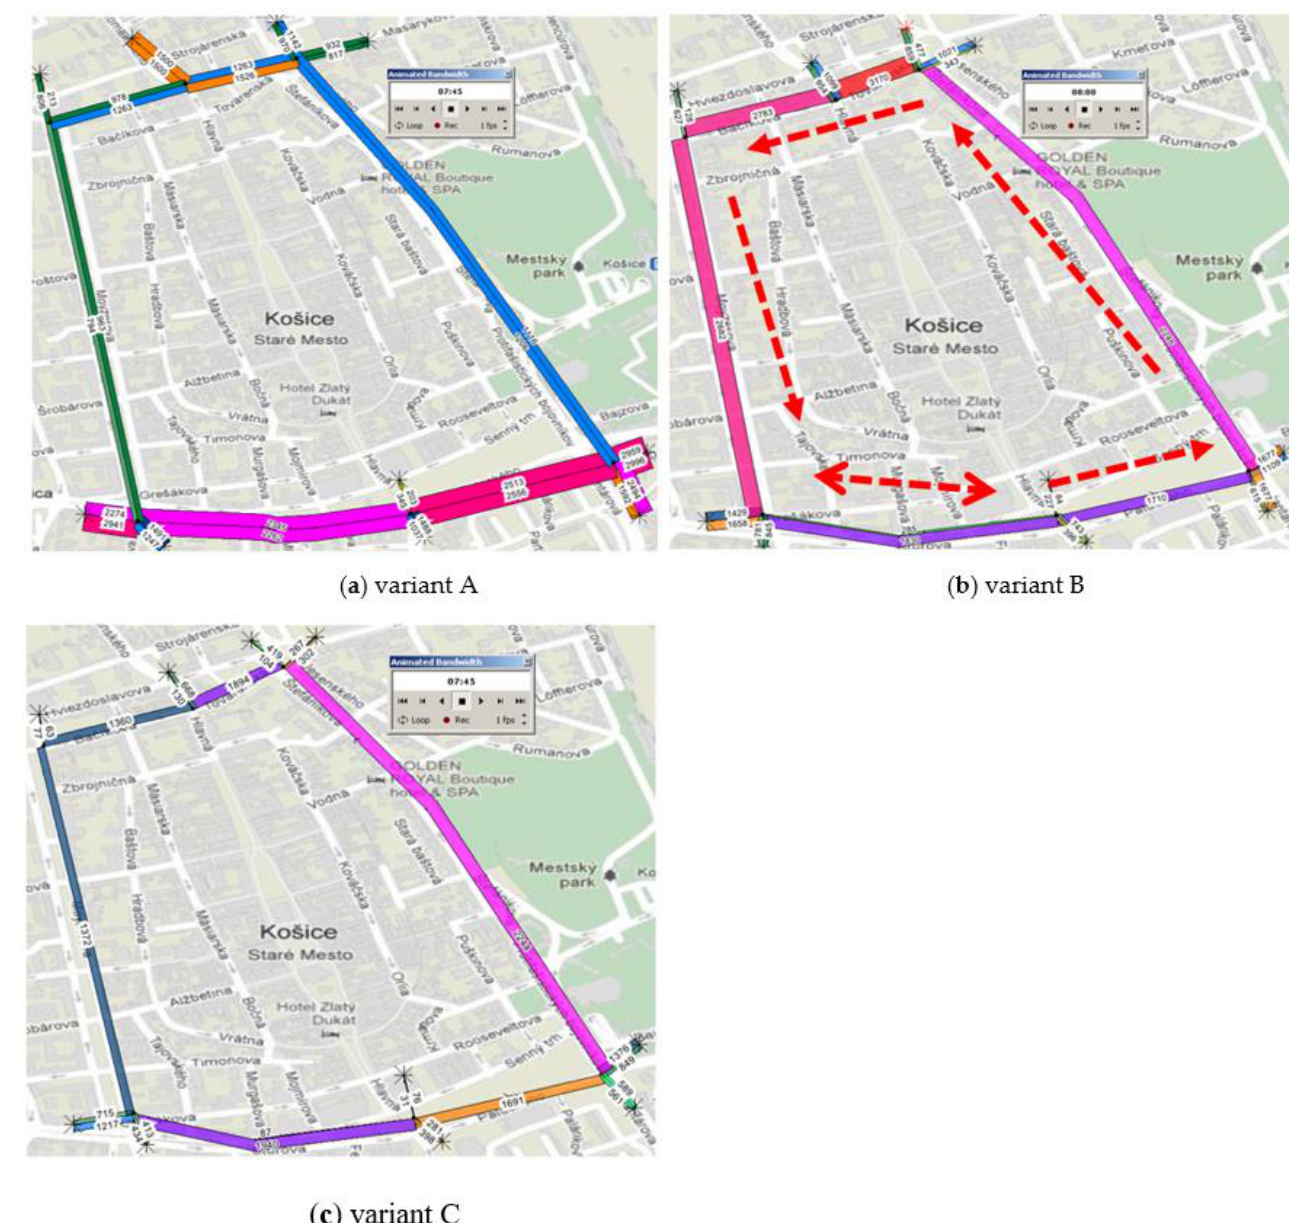
Figure 11. Traffic intensities of areas between the particular intersection (source elaborated by authors).